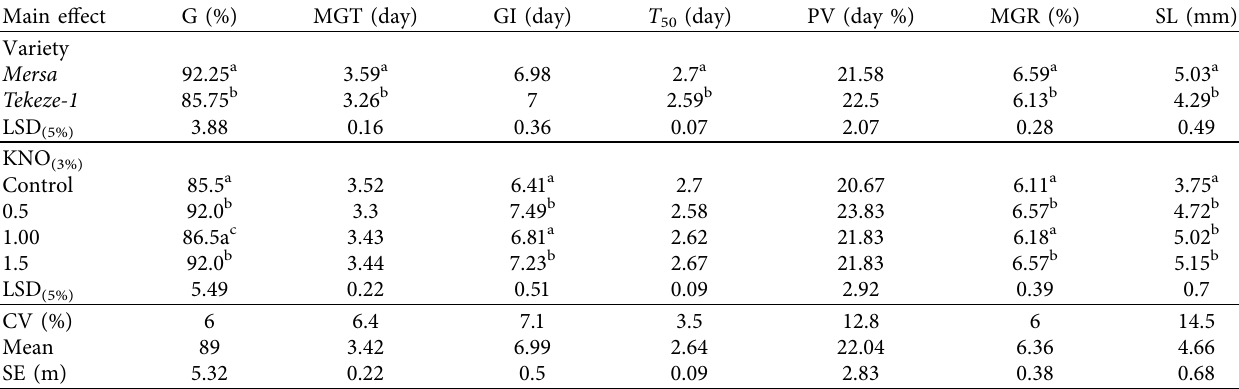
Table 2: Effect of priming with KNO 3 on the germination parameters and shoot length of tomato varieties. Main effect